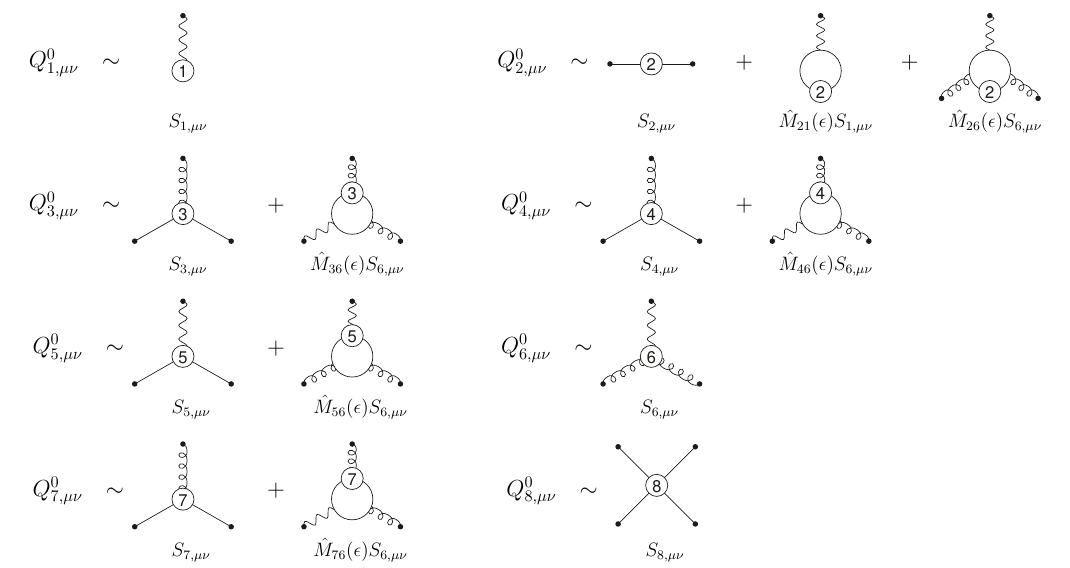
Figure 4 . Topologies involved in the computation of the matrix ^ M ( (cid:15) ). All the possible permuta- tions of the bosonic lines attached to the fermion loops must be considered. The numbered circles refer to the operators de(cid:12)ned in (3.1){(3.8). The \outside" black dots form the operators that mix